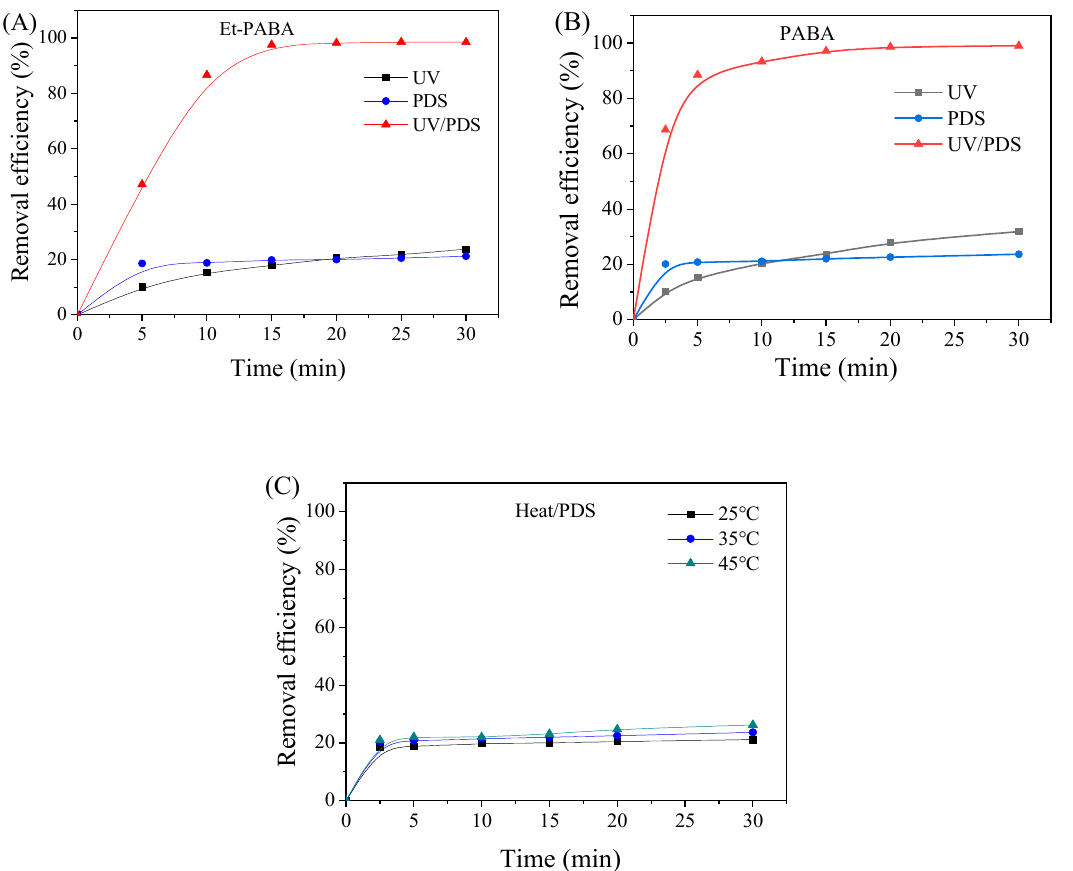
Figure 2. Removal e ffi ciencies of ( A ) Et-PABA and ( B ) PABA using di ff erent oxidation processes; Figure 2. Removal efficiencies of ( A ) Et-PABA and ( B ) PABA using different oxidation processes; ( C ) ( C ) removal e ffi ciency of Et-PABA using persulfate (PDS) activated by heat energy. Conditions: removal efficiency of Et-PABA using persulfate (PDS) activated by heat energy. Conditions: [Et- [Et-PABA] = [PABA] = 0.05 mM, [PDS] = 2 mM, and without pH PABA] = [PABA]= 0.05 mM, [PDS] = 2 mM, and without pH adjustment.